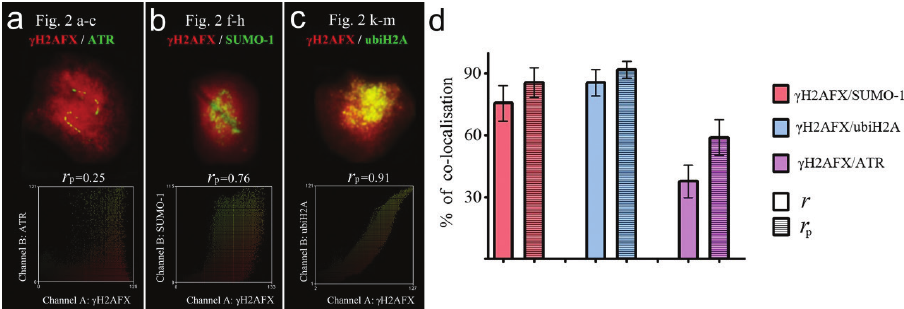
Figure 4. Intensity correlation analysis (ICA) represented by scatter plots showing the paired intensities of two channels ( a γ H2AFX - ATR, Fig. 2a–c b γ H2AFX - SUMO-1, Fig. 2f–h c γ H2AFX - ubiH2A Fig. 2k-m). r - Pearson correlation coefficient. See more details in the text. Degree of co-localisation for signals p in sex trivalents of common shrew ( d ). On the y -axis, the percentage of co-localised signals are shown ac- cording to overlap correlation coefficients ( r ) and the Pearson correlation coefficient ( r